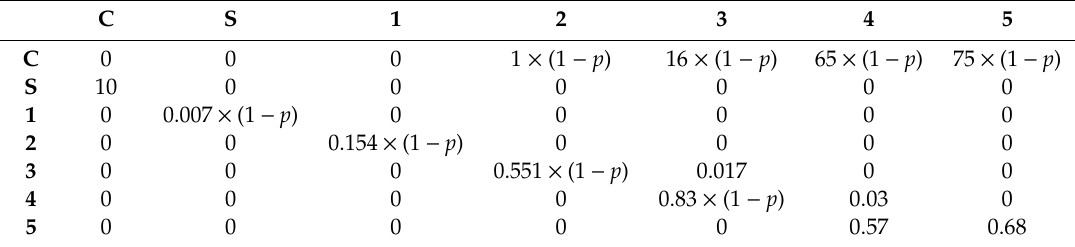
Table 4. Projection matrix with transition probability values calculated from Monterey pine demographic data and estimates for cone production and seed release / germination included with classes corresponding to cones (C), seeds (S), seedlings (1), small saplings (2), medium saplings (3), large saplings (4), and mature trees (5). Some parameters are a ff ected by pitch canker disease ( p ) and are thus multiplied by (1 − p